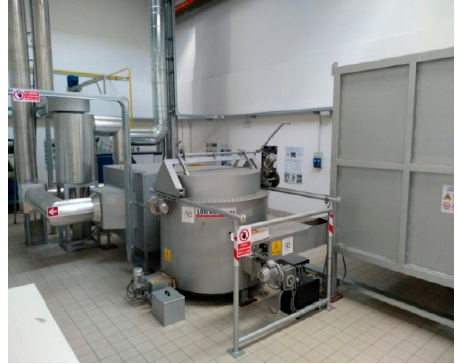
Figure 1. The investigated combined heat and power biomass plant.